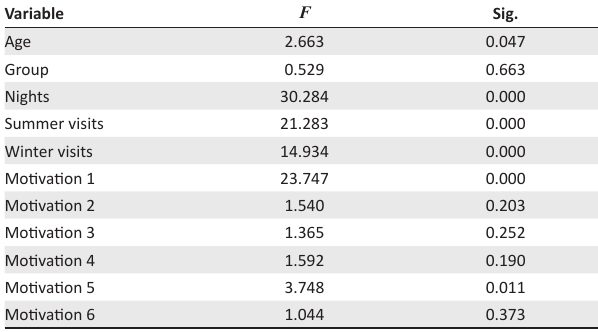
TABLE 3-A1: Summary of analysis of variance results.